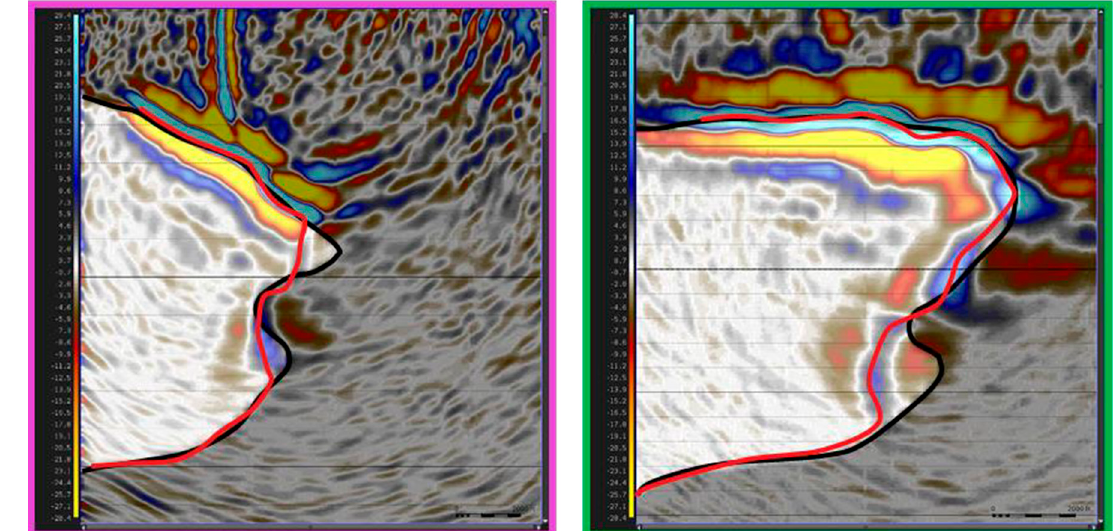
Figure 6. Legacy and DAS-VSP salt imaging, taken along two perpendicular lines. In both lines, the legacy salt interpretation (black) agrees with the DAS-based image (red) for the top of the salt. However, there are significant differences in the salt flank. Figure from Duan et al. (2020), SEG Annual Meeting Expanded Abstracts.